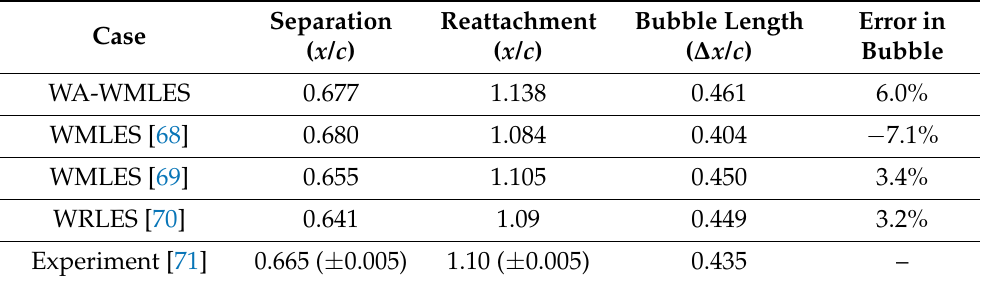
Table 4. Comparison of separation and reattachment locations for NASA hump flow. Note that all WMLES cases use the equilibrium wall